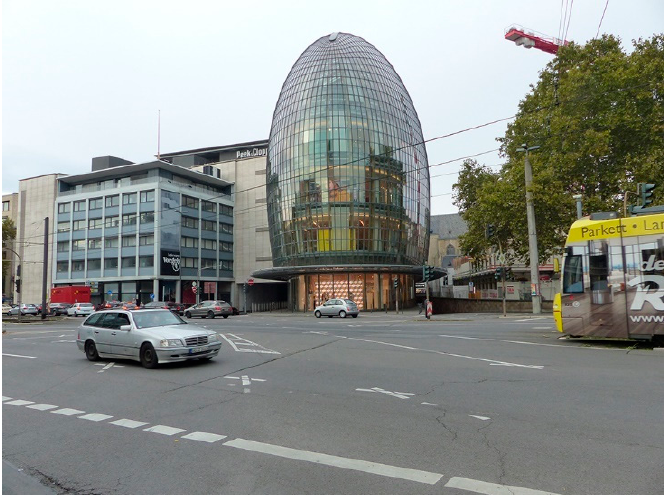
Figure 2. View of a fragment of the “Weltstadthaus” and the church of St. Anthony in Cologne, from the side of the Cäcilienstra β e arterial (image 2).